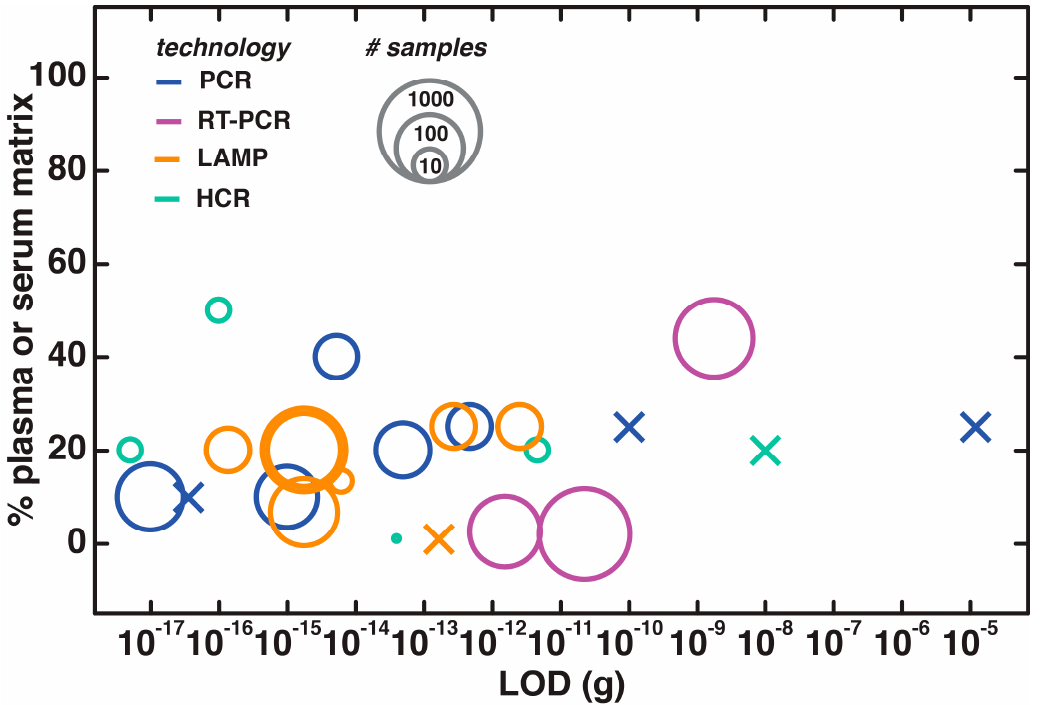
Figure 5. Serum and plasma-based nucleic acid testing, with data presented as in Figure 3.